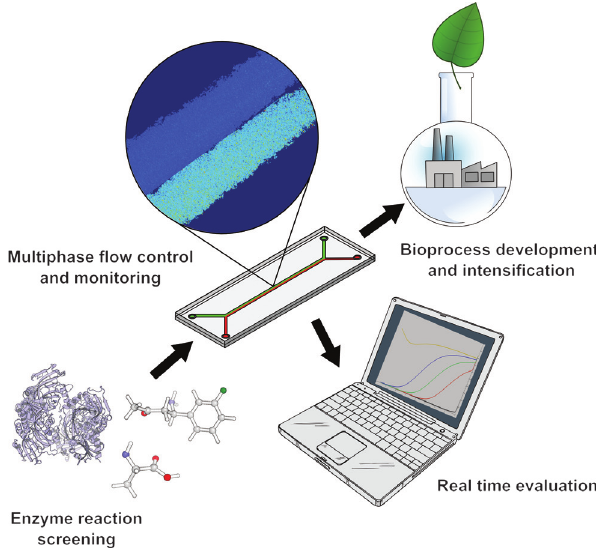
Figure 1 Instrumented multiphase microstructured reactors are powerful tools for biocatalytic process development, providing potential process intensification at different phases of the develop- ment